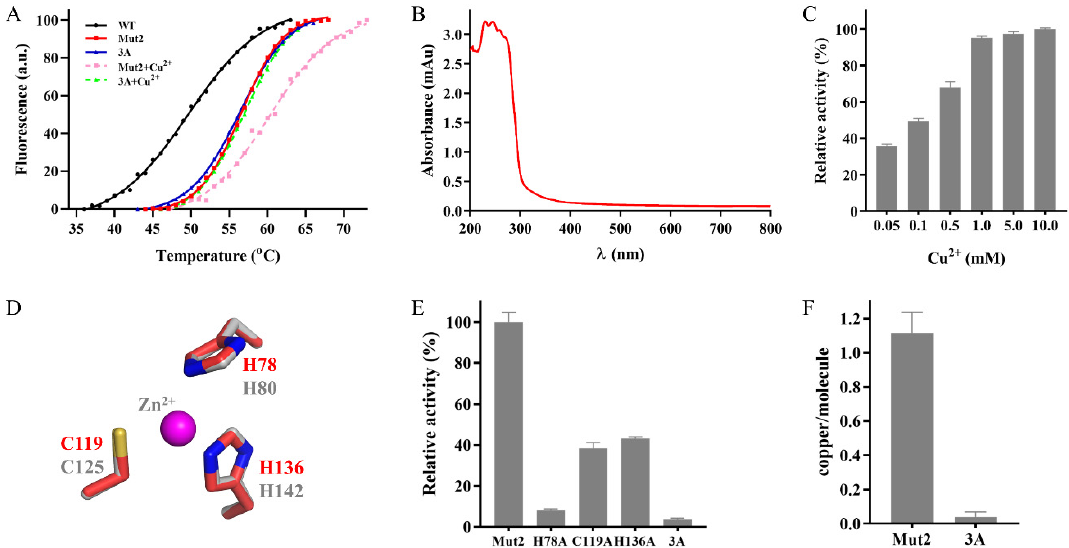
Figure 4. Identification of the putative copper binding site. ( A ) The effect of Cu 2+ on the thermostability of Ghlac using the Thermofluor assay. The T m values of Ghlac WT, Mut2, 3A, Mut2 with Cu 2+ (Mut2+Cu 2+ ), and 3A with Cu 2+ (3A+Cu 2+ ) were 49.5 ± 0.2 ◦ C, 56.4 ± 0.2 ◦ C, 56.4 ± 0.1 ◦ C, 60.9 ± 0.6 ◦ C, and 56.2 ± 0.1 ◦ C, respectively. ( B ) The UV/visible spectrum of Mut2. ( C ) The effect of Cu 2+ on the activity of Mut2. ( D ) Superposition of the putative copper binding sites of Mut2 and GsYlmd (PDB: 6T0Y). The residues of Mut2 and GsYlmd were labeled in red and grey, respectively. Zn 2+ in GsYlmd was shown as a magenta sphere. ( E ) The laccase activity of Mut2 and its variants. ( F ) The copper content of Mut2 and the variant 3A determined by ICP-MS.